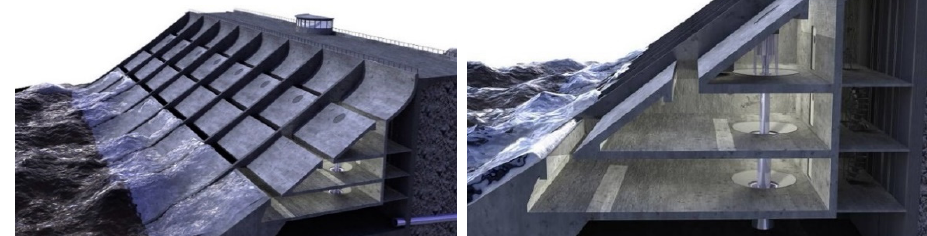
Figure 30. Views of the small-scale Wave Dragon ( left ) (Reproduced with permission 5139270373963 from [32], Elsevier, 2010) and its working principle ( right ) (Reproduced with permission 5139270591282 from [99], Elsevier, 2009). The last OD project is called Seawave Slot-Cone Generator, depicted in Figure 31 [3,100]. This system is designed for onshore installation.